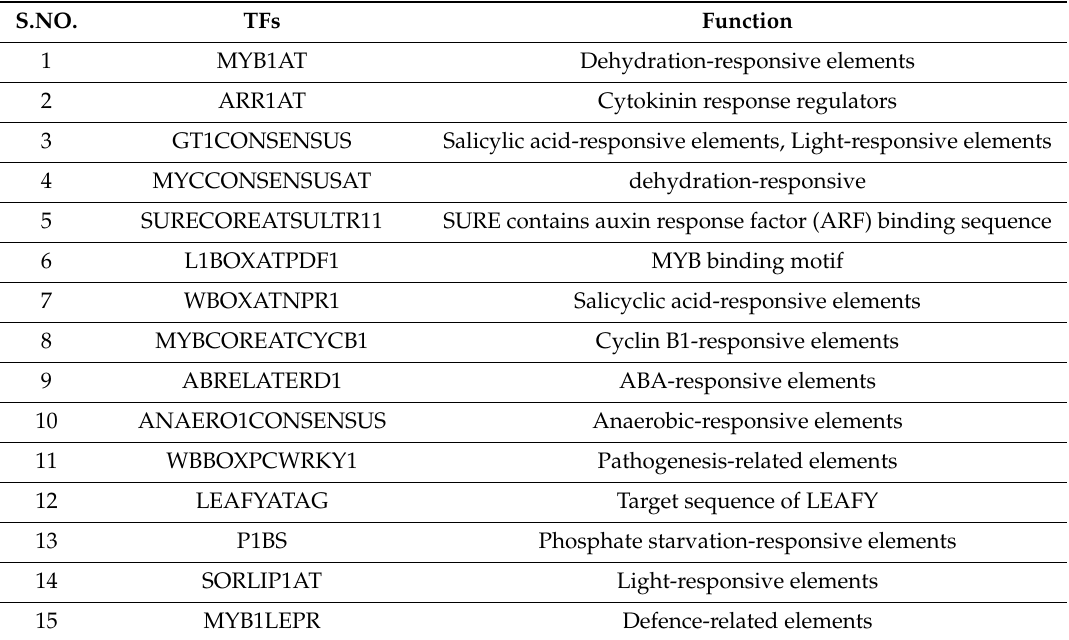
Table 1. List of common transcription factor (TF) binding sites in NDL1 , NDL2 , and NDL3 promoter. S.NO.